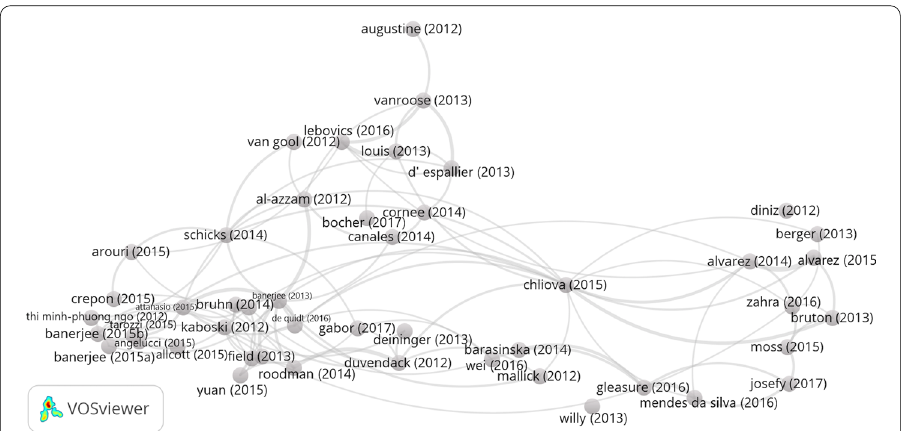
Fig. 5 Knowledge map of the top articles cited by cluster according to the fractional counting method, based on 524 studies selected between 1:2012 and